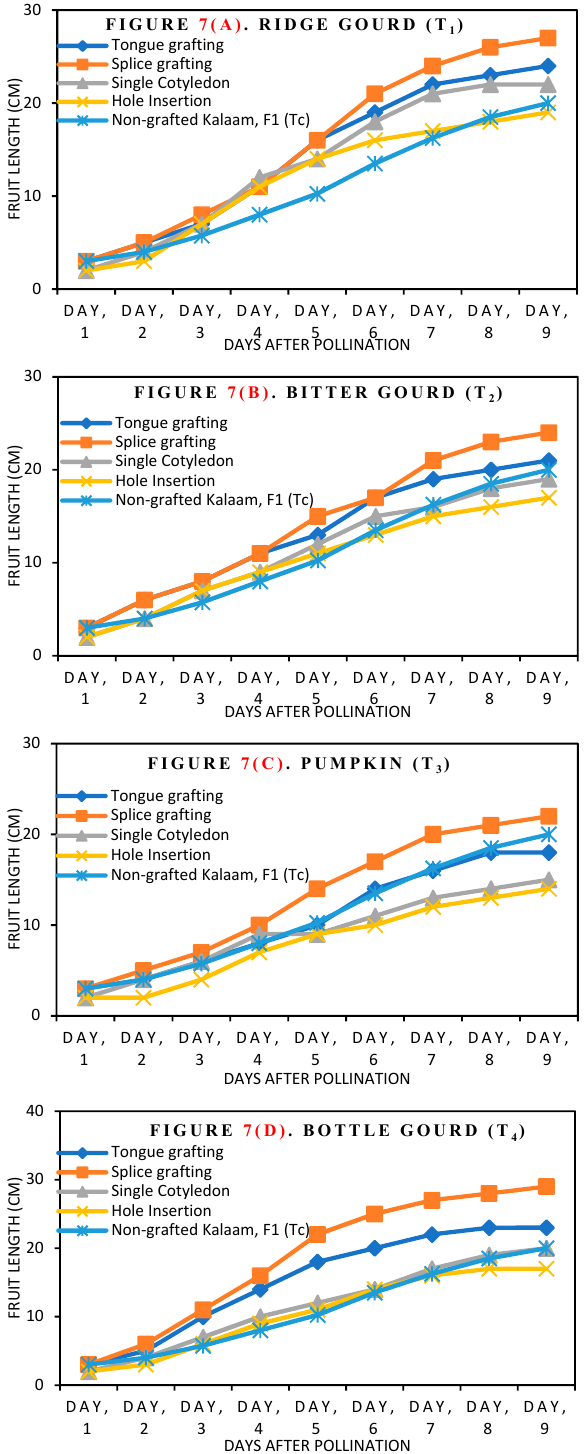
Figure 7. ( A – D ). E ff ect of grafting on Cucumber fruit development (fruit length) after Figure 7. (A, B, C, D). Effect of grafting on Cucumber fruit development (fruit length) after pollination.